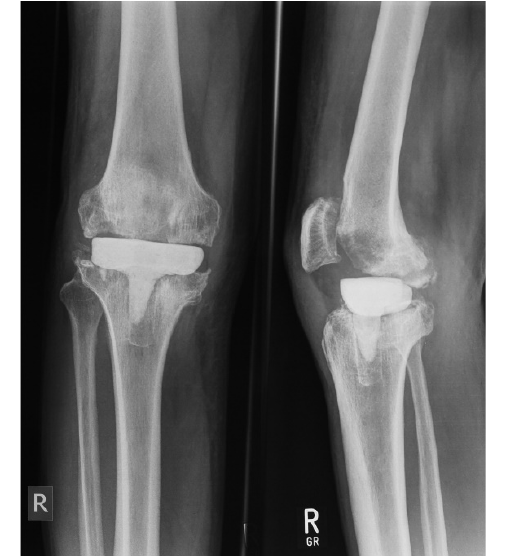
Figure 4: Anteroposterior and lateral radiographs of a static knee spacer in situ.